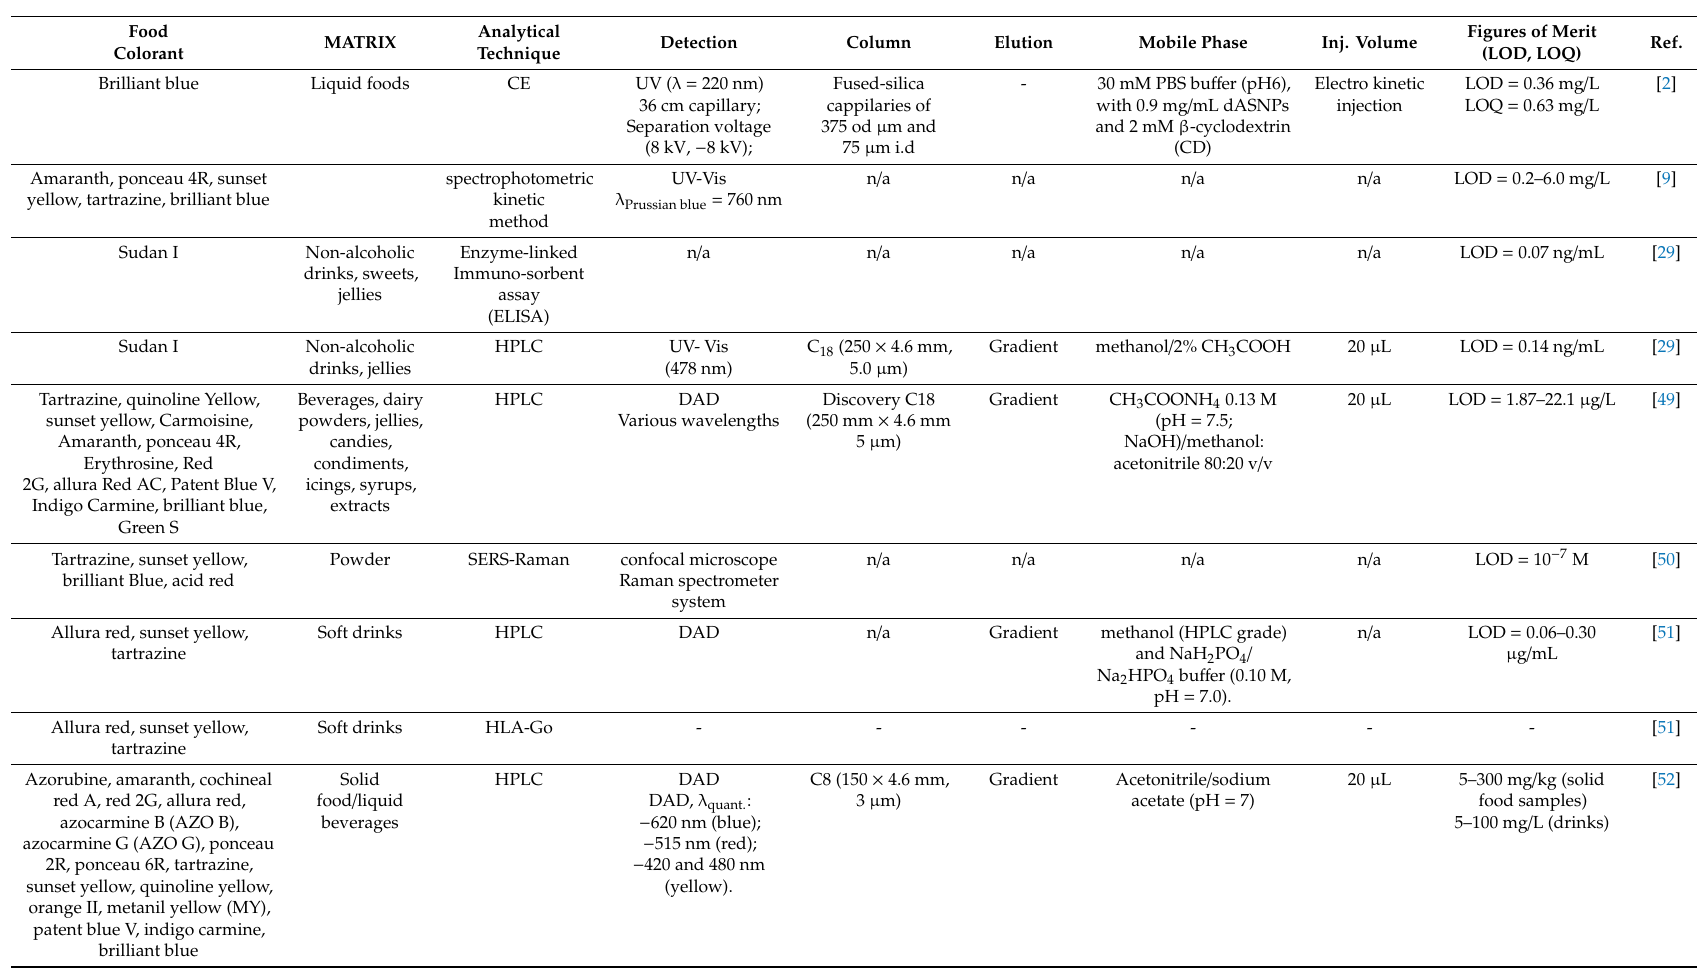
Table 3. Analytical techniques for the determination of natural food colorants in food